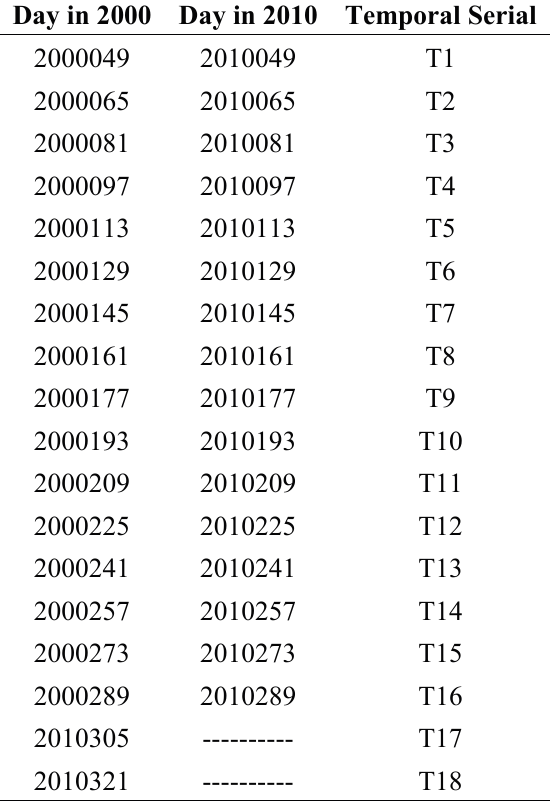
Table 2. EVI temporal series in 2000 and 2010 (format of the days: